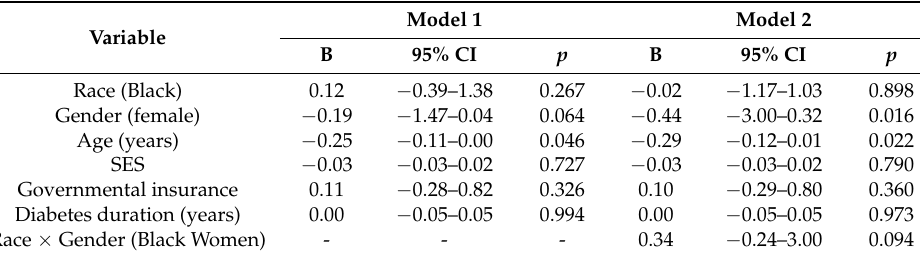
Table 3. Summary of linear regression in the pooled